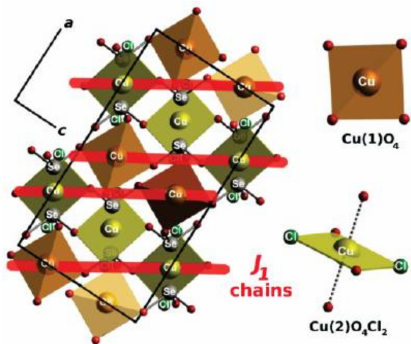
Figure 8. (left) Crystal structure of CaCu 2 (SeO 3 ) 2 Cl 2 . The structural chains run along [10¯1] (not shown), whereas the magnetic chains range along ∼ [201], as shown by bold (red) lines. Small unlabeled spheres denote O atoms. (right) Local environment of Cu(1) and Cu(2). The magnetically active Cu(1)O 4 and Cu(2)O 2 Cl 2 plaquettes are highlighted. Reprinted figure with permission from [28] Copyright (2011) by the American Physical